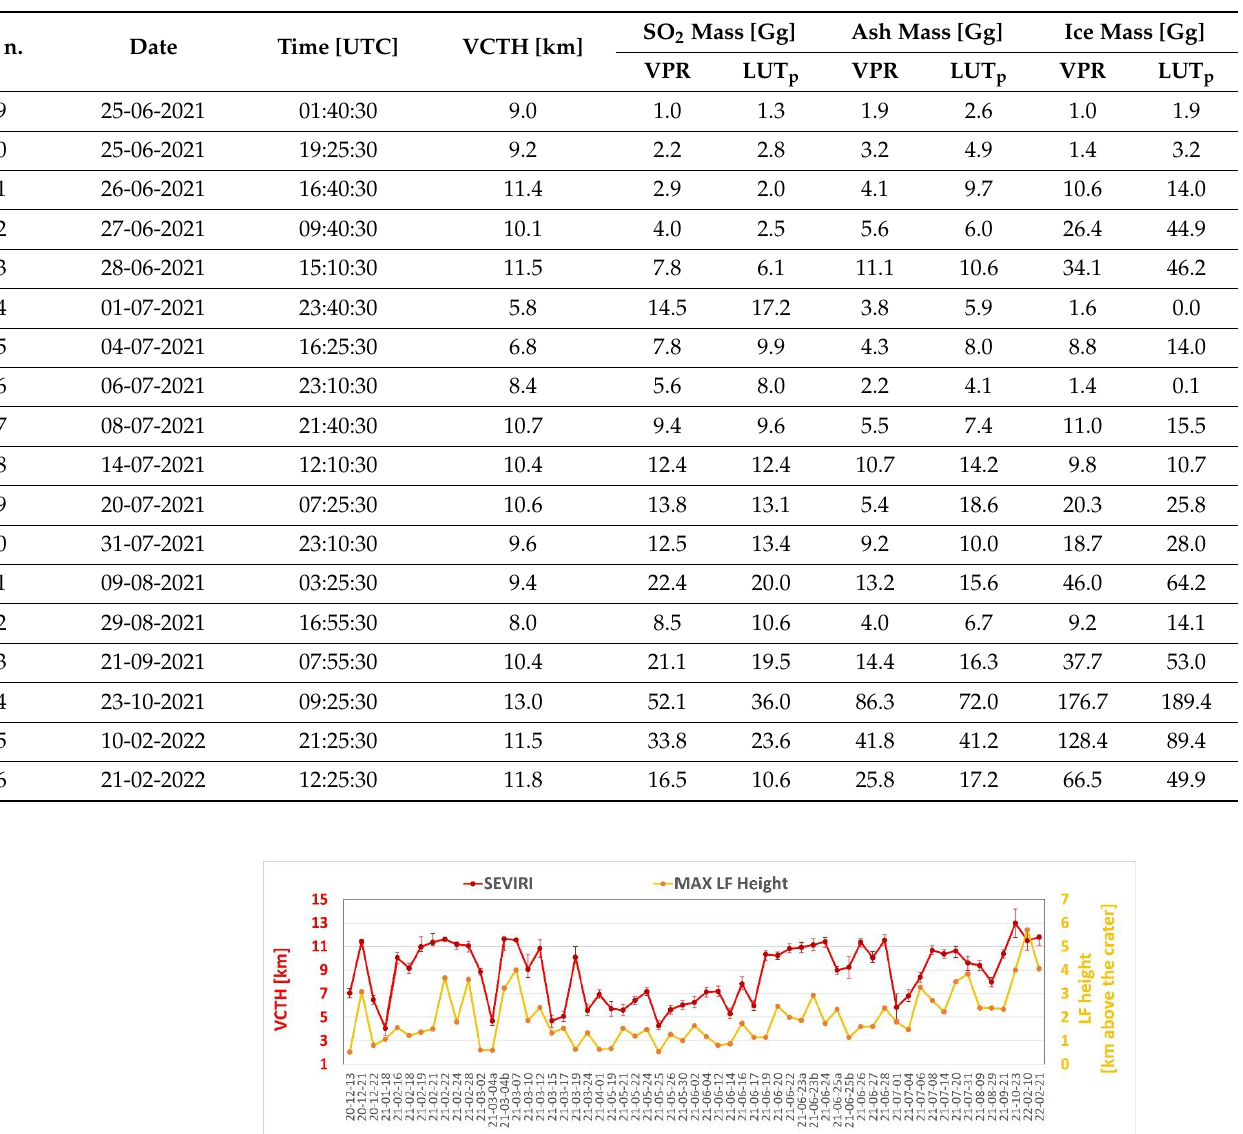
Figure A1. Comparison between the SEVIRI-VCTH and the maximum LF height obtained from TIR ground-based cameras by Calvari and Nunnari [24].